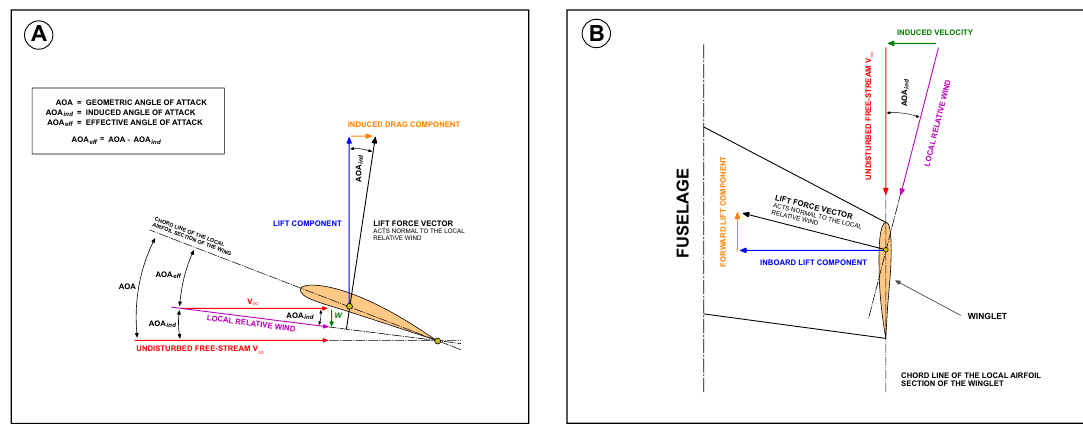
Figure 4. ( A ) Illustration of lift-induced drag due to downwash; ( B ) Illustration of forces generated at the